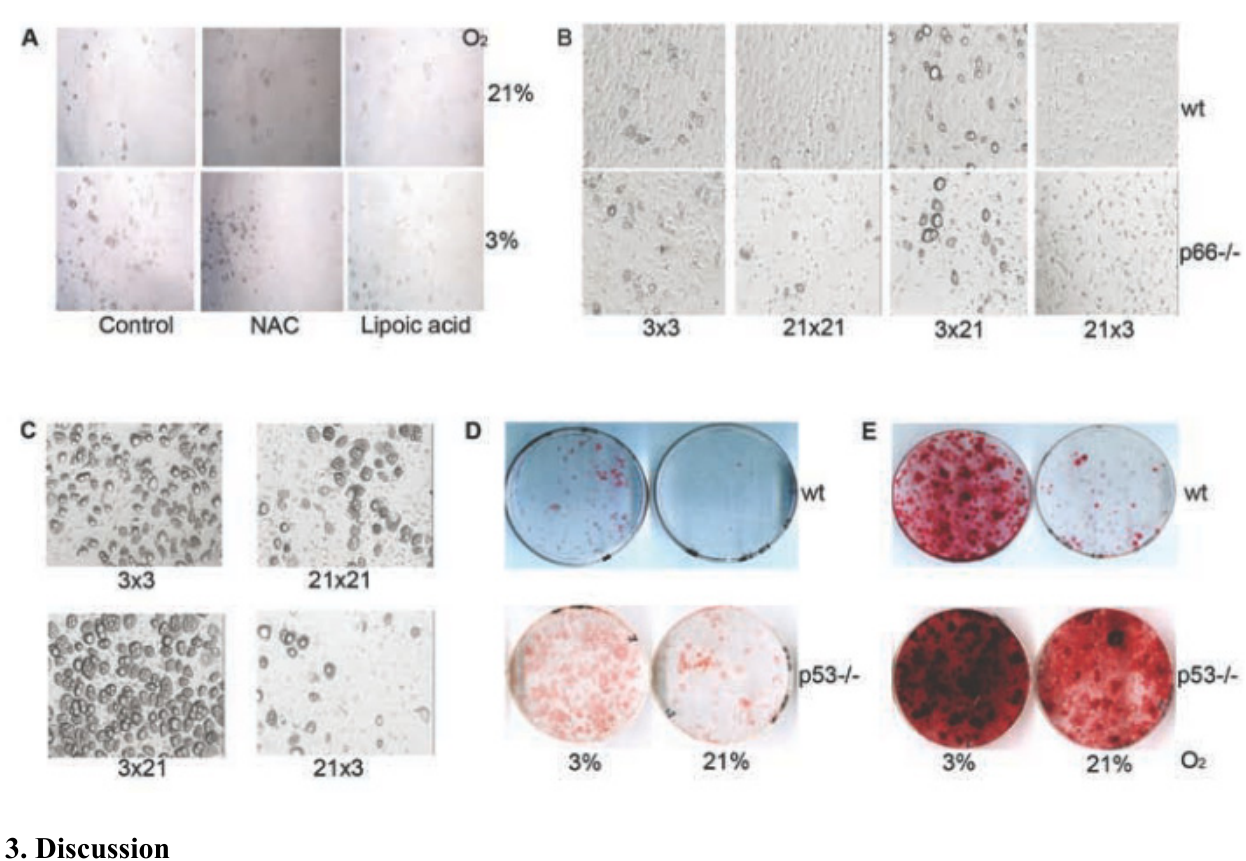
Figure 6. Effect of 3% O on BMSC differentiation is independent of ROS and p53. 2 in ( A ) Representative pictures of BMSC cultured and differentiated in 3% or 21% O 2 standard adipocyte differentiation media (control) or supplemented with NAC or lipoic acid; ( B ) Representative pictures of BMSC isolated from wild type (wt) and p66 Shc − / − mice (21 × 21); or and propagated and differentiated into adipocytes in 3% (3 × 3) or 21% O 2 propagated in 3% O and differentiated in 21% O (3 × 21), or vice versa (21 × 3); 2 2 ( C ) Representative images of p53 − / − BMSC propagated and differentiated in 3% (3 × 3) or (21 × 21); or amplified in 3% O and differentiated in 21% O (3 × 21), or 21% O 2 2 2 vice versa (21 × 3); ( D ) Oil Red O staining of wt and p53 − / − BMSC stimulated to adipocytic differentiation in CFU-A; ( E ) Alizarin Red S staining of wt and p53 − / − BMSC stimulated to osteocytic differentiation in